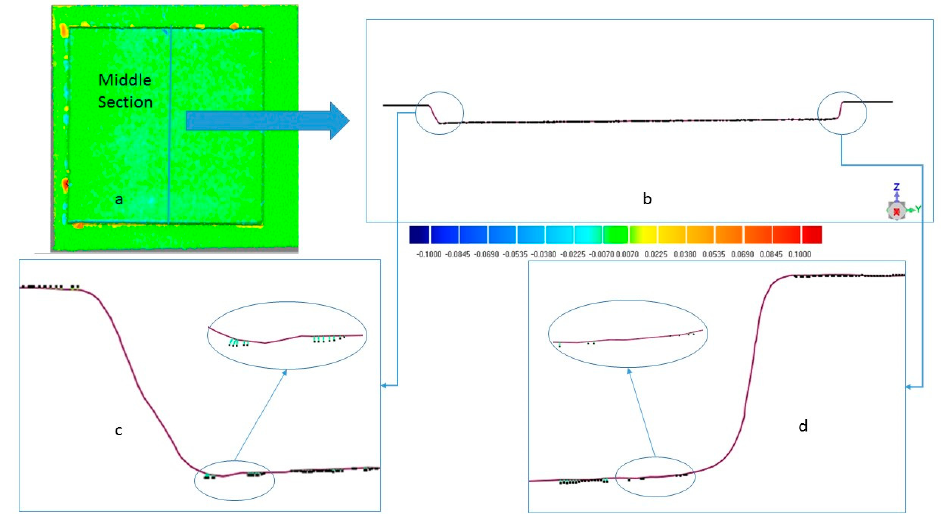
Figure 5. Comparison CH- optical profilometer for benchmark number 1. ( a ) Superimposition between CH and Taylor Hobson CCI MP-HS profilometer 3D models, ( b ) Middle Section, ( c ) Zoom of left angle (in violet the profile obtained from CH and in black the profile obtained from the profilometer), ( d ) Zoom of the right angle.